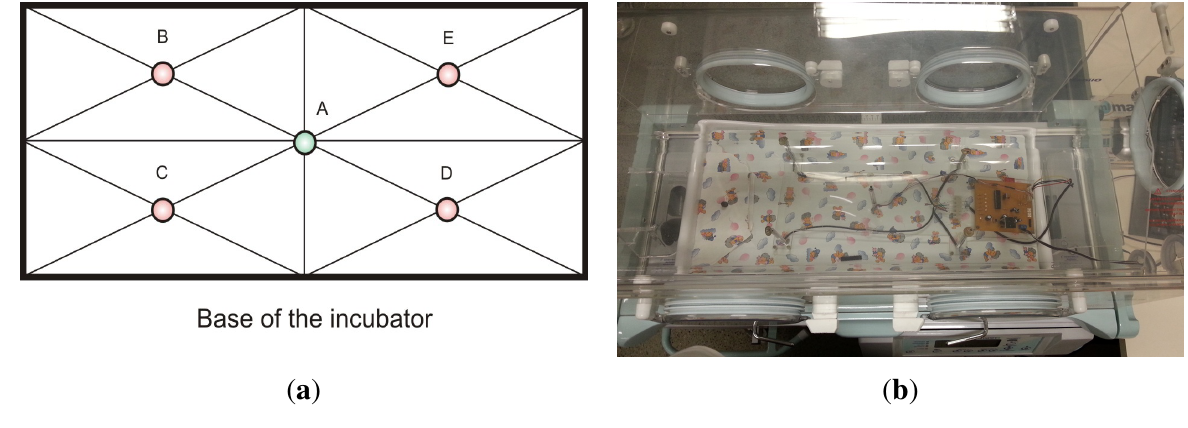
Figure 6. A scheme ( a ) and an overview of the sensor positioning inside the neonatal incubator ( b ) according to standard IEC